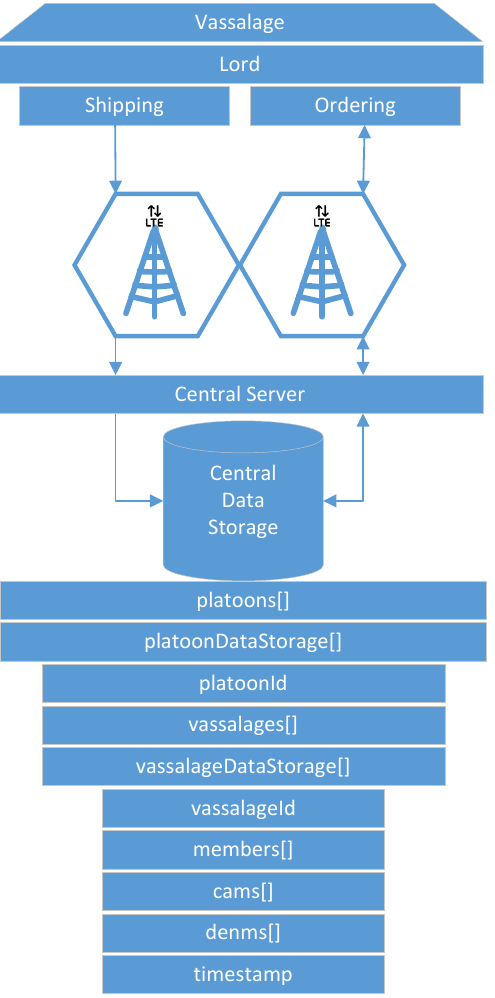
Figure 6. Lord shipping/ordering vassalage data to/at central data storage. Data are stored per platoon and per